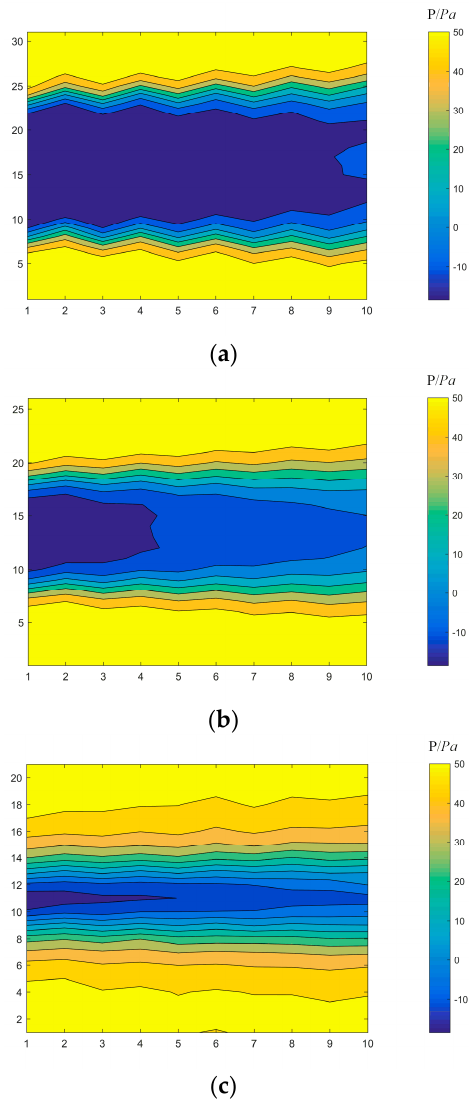
Figure 10. Pressure cloud diagram of flow around cylinders with diameters of ( a ) 9 cm, ( b ) 5 cm, and ( c ) 3 cm.